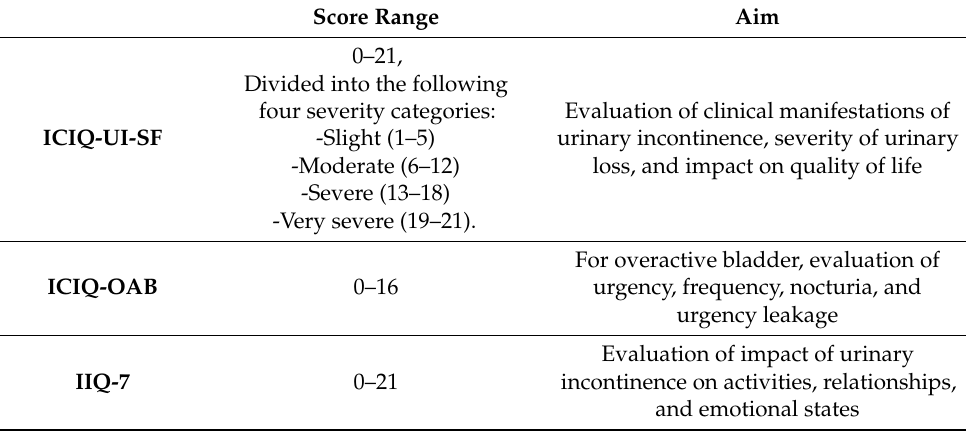
Table 2. Evaluation questionnaires.